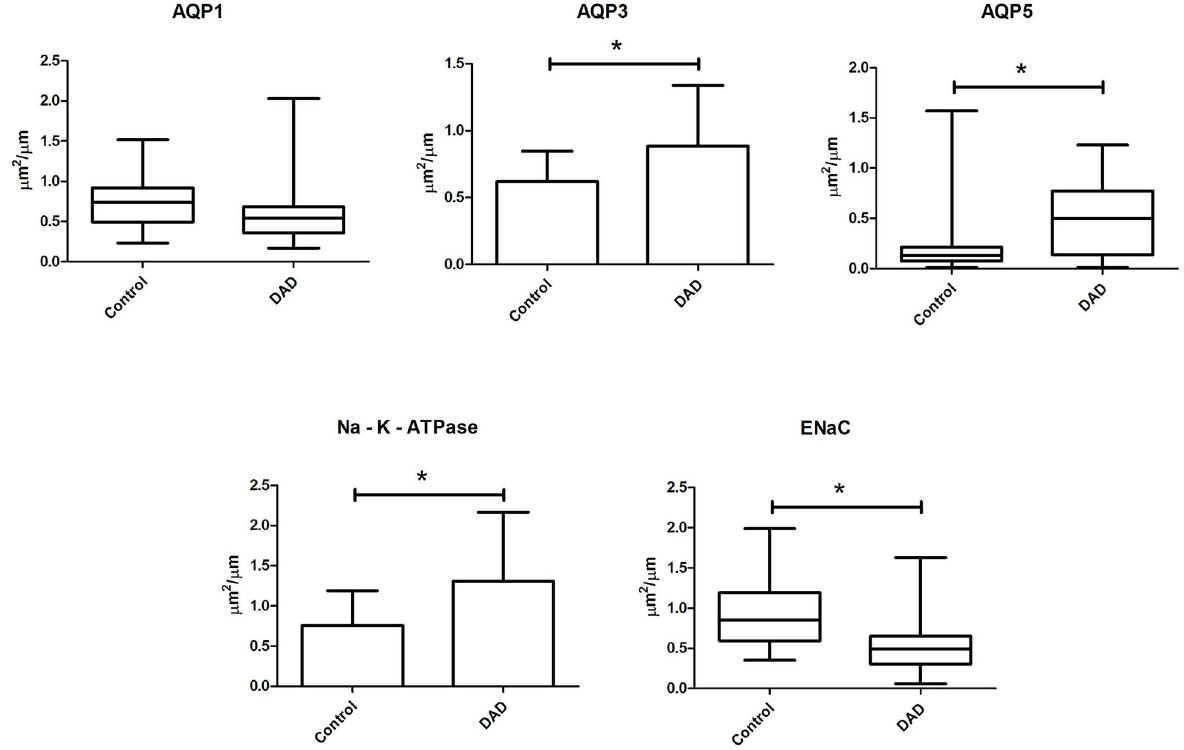
Fig 3. Aquaporin and ion channels expressionin the alveolar septum of control and DAD groups.